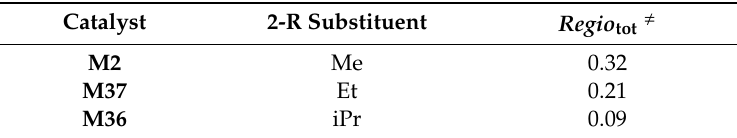
Table 3. 2-R substituent size vs. catalyst regioselectivity.